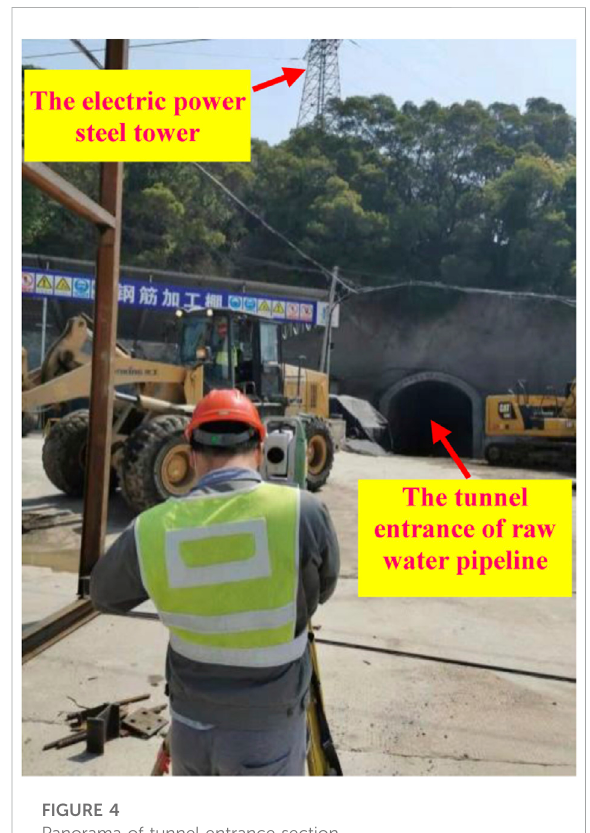
FIGURE 4 Panorama of tunnel entrance section.